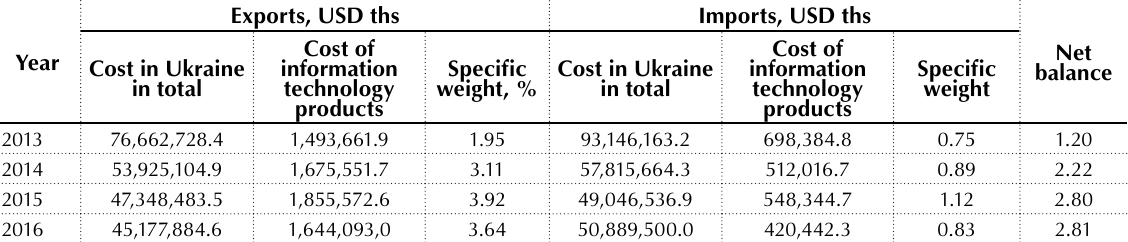
Table 2. Dynamics of exports and imports of telecommunications, computer and information services in Ukraine in 2013–2016‎ Source: Exports and imports dynamics, Government statistics of Ukraine.